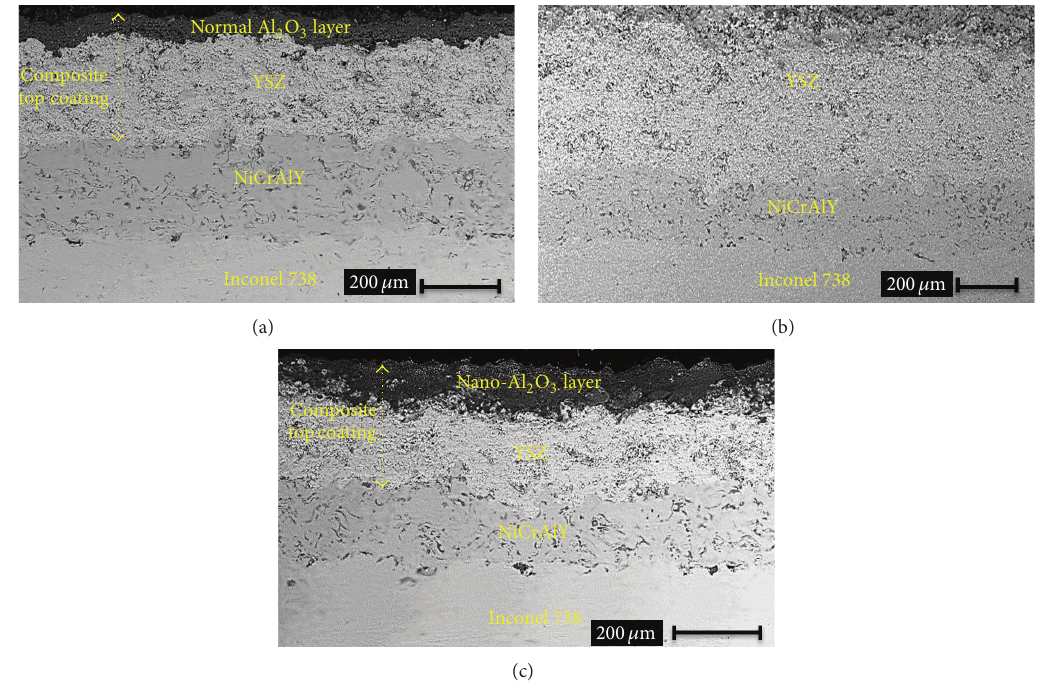
Figure 4: Cross-section of the as-sprayed